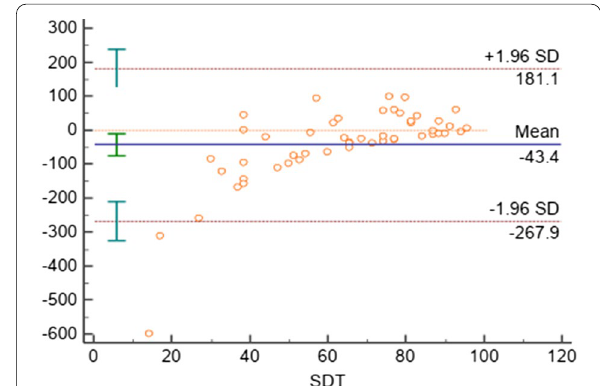
Fig. 1 Test for agreement between CSQND and